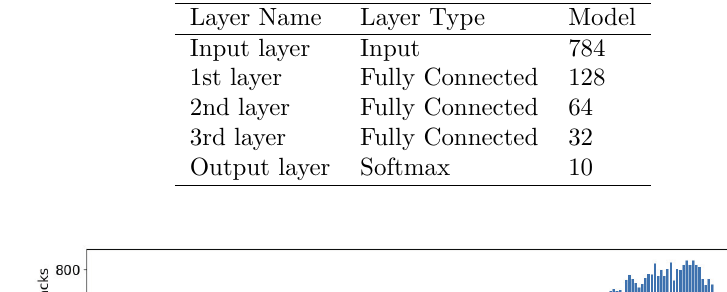
Table 1: MLP model architecture for MNIST dataset